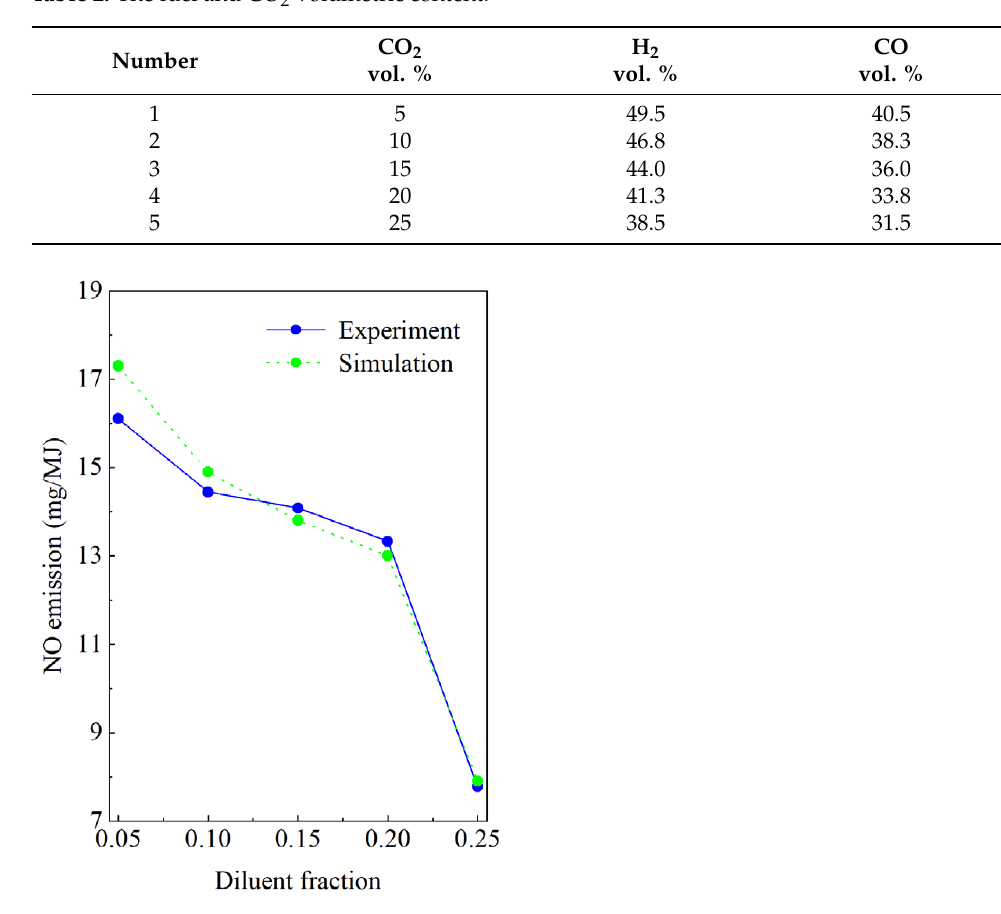
Figure 3. Comparison of the experimental and simulated NO emission. Table 2. The fuel and CO 2 volumetric content.